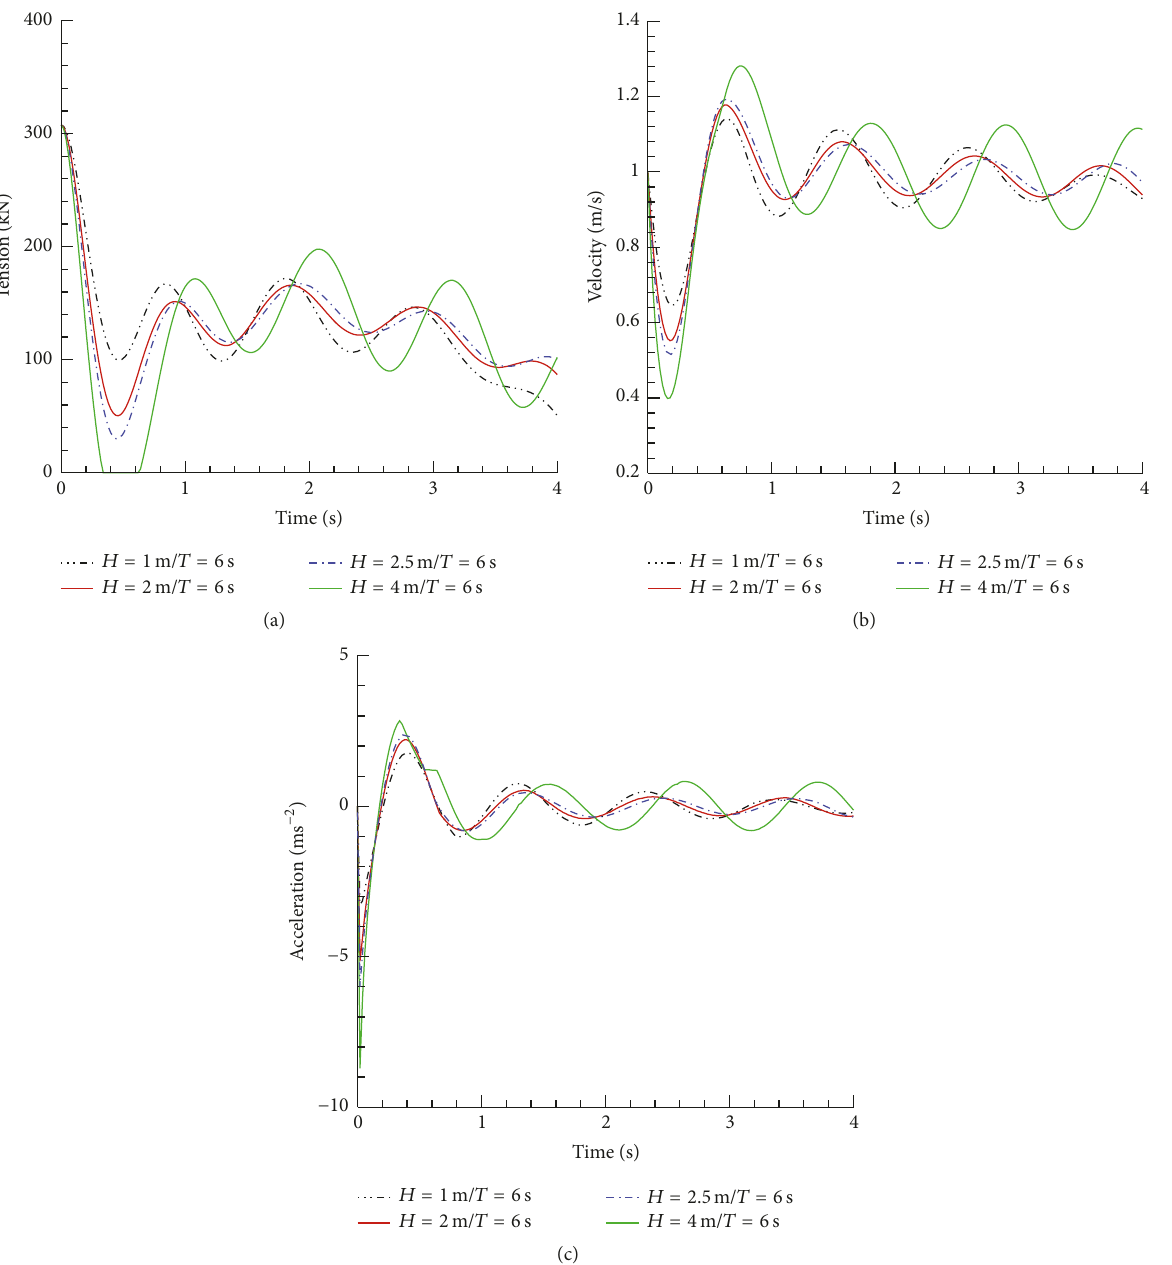
Figure 11: Influence of wave heights: (a) tension acting on the cylinder; (b) velocity of the cylinder; (c) acceleration of the cylinder.